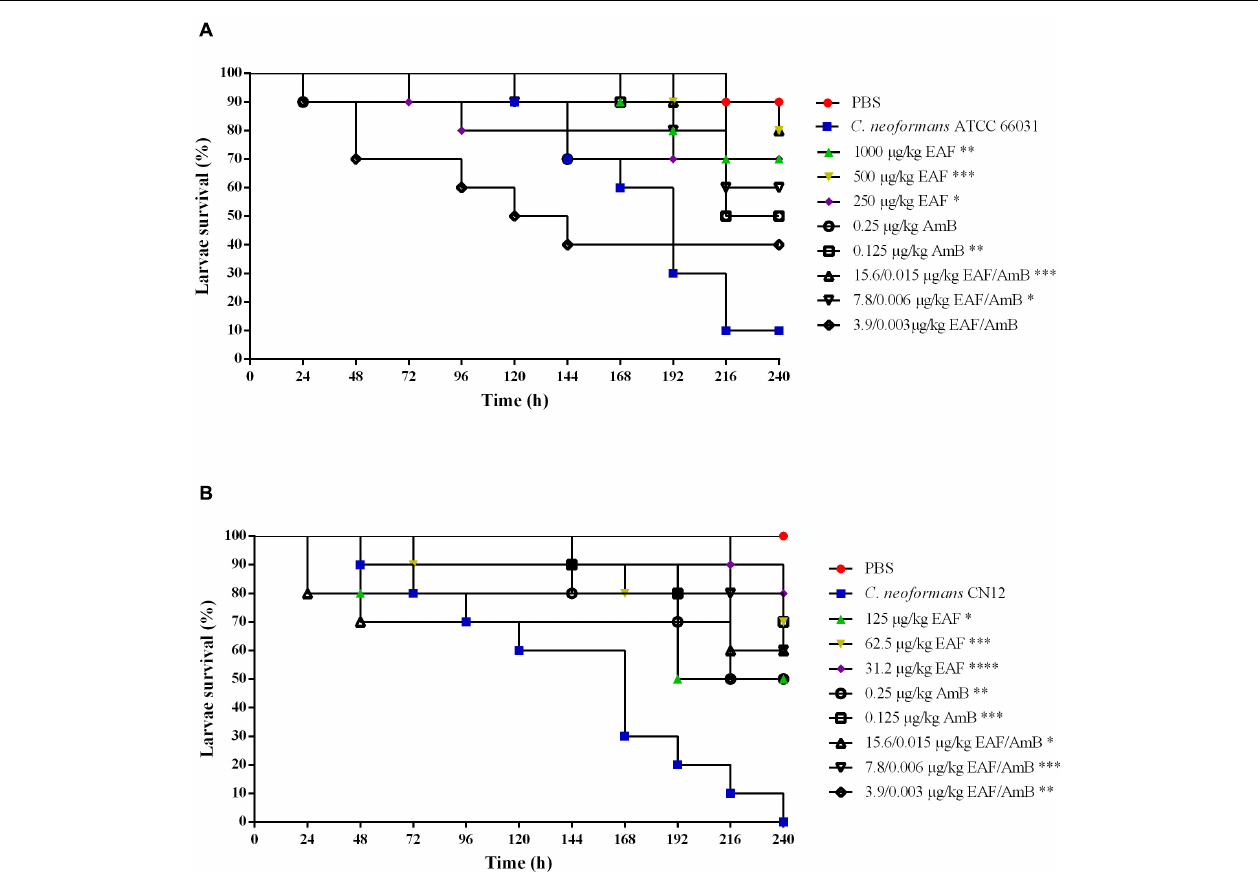
FIGURE 7 | Effect of ethyl acetate fraction (EAF) of Poincianella pluviosa bark and amphotericin B (AmB) alone or in combination against Galleria mellonella larvae infected with Cryptococcus neoformans ATCC 66031 (A) and Cryptococcus neoformans CN12 (B) . All groups were compared with infected and untreated larvae. Analysis of G. mellonella survival data was performed using the log-rank (Mantel–Cox) of representative experiment. The asterisks indicate a significant reduction in mortality rate of infected and treated group compared with the infected and untreated group (* p < 0.05; ** p < 0.01; *** p < 0.001; **** p < 0.0001). (A) Kaplan–Meier plots of survival curves of G. mellonella larvae infected with Cryptococcus neoformans ATCC 66031. The larvae were infected with fungal cells and concomitantly treated with minimal inhibitory concentration (MIC), 0.5 × MIC, or 0.25 × MIC of EAF (1,000.0, 500.0, or 250.0 µ g/ml/kg of larvae, respectively), 2 × MIC and MIC AmB (0.25 or 0.125 µ g/ml/kg of larvae, respectively), and EAF combined with AmB (15.6/0.015, 7.8/0.006, or 3.9/0.003 µ g/ml/kg of larvae) at the synergistic concentrations. (B) Kaplan–Meier plots of survival curves of G. mellonella larvae infected with C. neoformans CN12. The larvae were infected with fungal cells and concomitantly treated with MIC, 0.5 × MIC, or 0.25 × MIC of EAF (125.0, 62.5, or 31.2 µ g/kg of larvae, respectively), AmB (0.25 or 0.125 µ g/kg of larvae, respectively), and EAF combined with AmB (15.6/0.015, 7.8/0.006, or 3.9/0.003 µ g/kg of larvae) at the synergistic